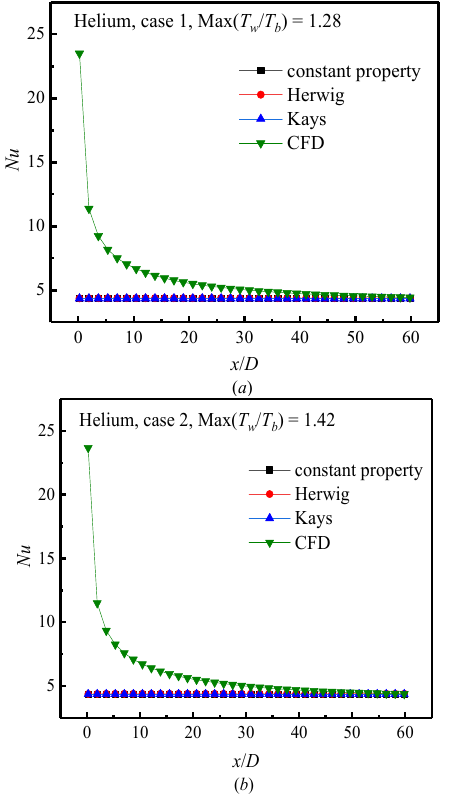
Energies 2023 , 16 , x FOR PEER REVIEW Figure 6. Calculations by existing Nu correlations for helium. ( a ) case 1; ( b ) case 2.